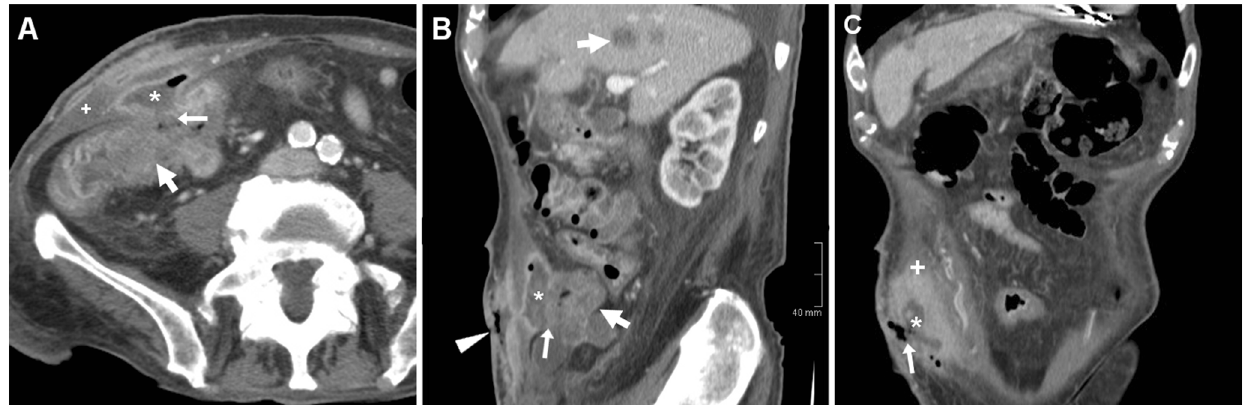
Fig. 14 Cutaneous fistulisation of colon carcinoma in a 92-year-old man with worsening right-sided abdominal pain and tenderness. CT detected a segmental, non-stratified circumferential thickening (thick arrows) at the ascending colon, which infiltrated the peritoneum, opened (arrows in A , B ) into an abscess (*) in the inflamed abdominal wall (+), and